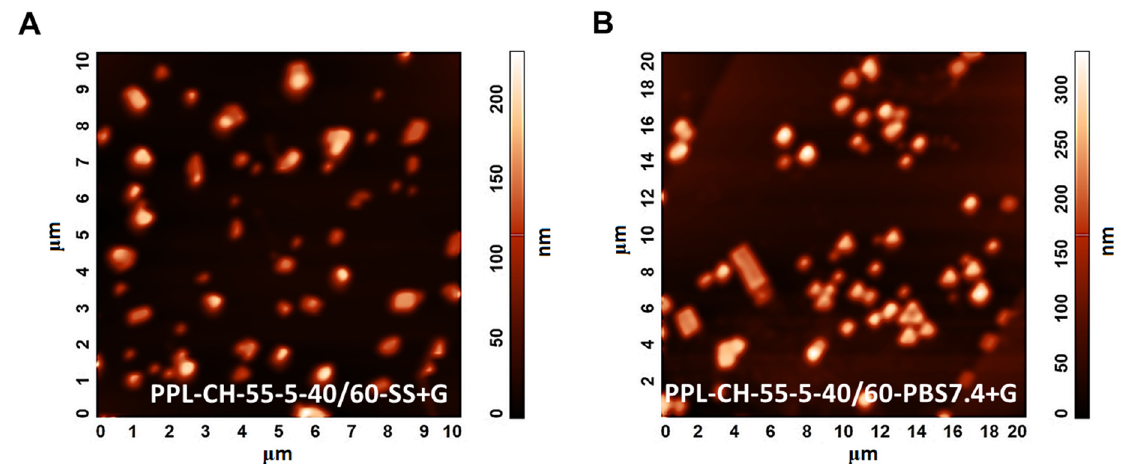
Figure 10. Atomic force microscopy images taken of the liposome samples prepared with different hydration media (saline solution ( A ), PBS pH 7.4 ( B )) from PC-DPPE-PEG 2000 -CH 55:5:40 mass ratio composition at 60 °C, and lyophilised with glucose as cryoprotectant.